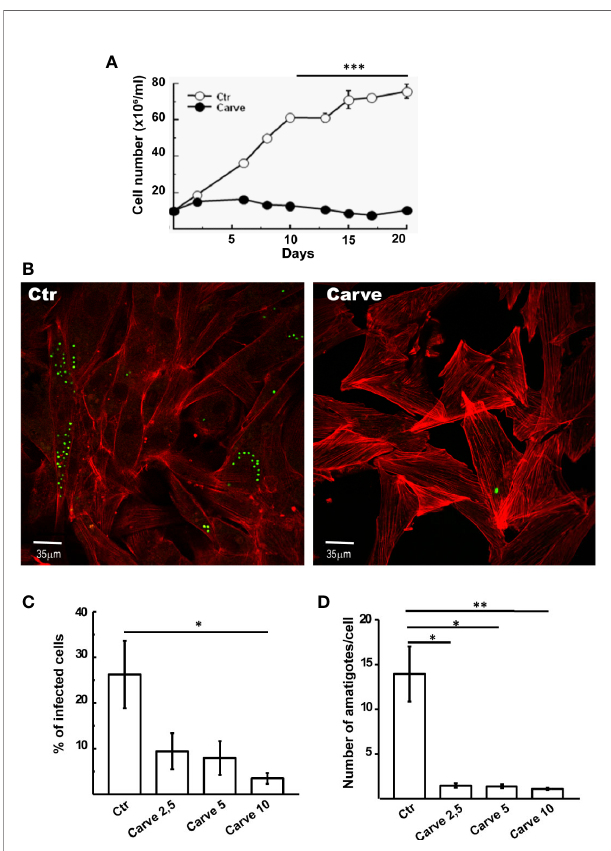
FIGURE 4 | Antiparasitic effect of carvedilol in epimastigotes and amastigotes of T. cruzi. (A) Epimastigotes (10x10 6 parasites/ml) of T. cruzi Y-GFP strain were incubated in the absence (DMSO, Ctr) or the presence of 10 m M carvedilol (Carve) at the indicated times. Data shown represent the mean +/- SE from 3 independent experiments. ***p < 0.001 (t-test). H9C2 cells were infected with trypomastigotes of T. cruzi Y-GFP strain (MOI=10) for 24 h followed by a chase of 48 h in the presence (Carve) or the absence (Ctr) of carvedilol at different concentrations (2.5, 5 and 10 m M). After fi xation, cells were prepared for microscopic studies. (B) Confocal images of GFP- expressing amastigotes multiplying within the host cells 48 h after treatment with 10 m M carvedilol versus control (DMSO). H9C2 cells actin myo fi brils were stained with rhodamine-phalloidine probe (red). Percentage of infected cells (C) and number of amastigotes/cell (D) at the different concentrations of carvedilol versus control. Data are shown as mean +/- standard error of 3 independent experiments. *p < 0.05, **p < 0.01 (Tukey test). A total of 100 cells per group was